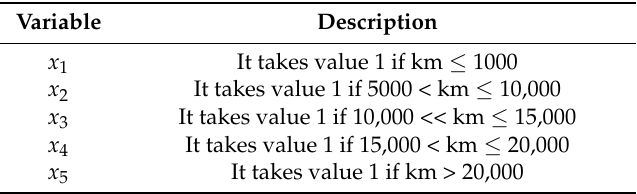
Table 6. Binary variables used for the segmentation of the distance traveled.